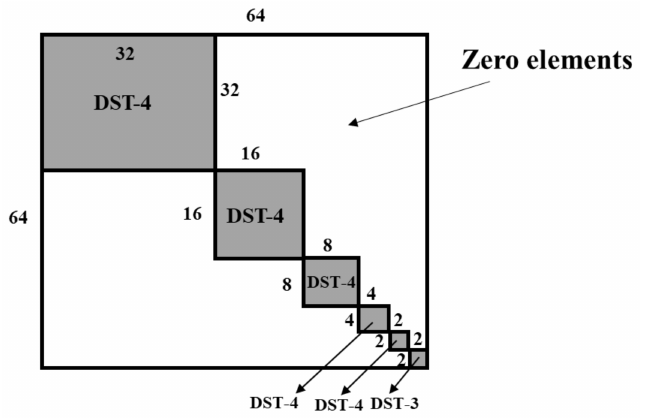
Figure 2. Structure of unified DST-3 matrix ( U